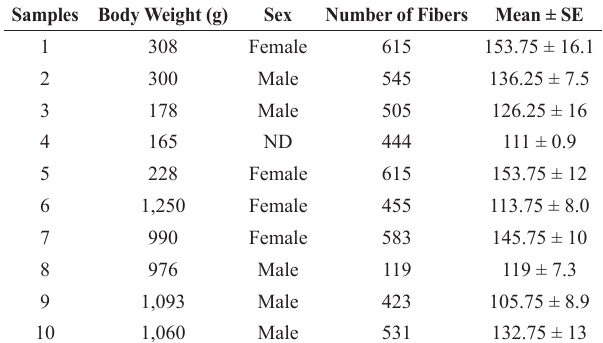
Table 1. Diameters of fibers in Colossoma macromum at 300 days old; body weight, sex, number of fibers sampled and means and standard error (±SE). (ND – Not